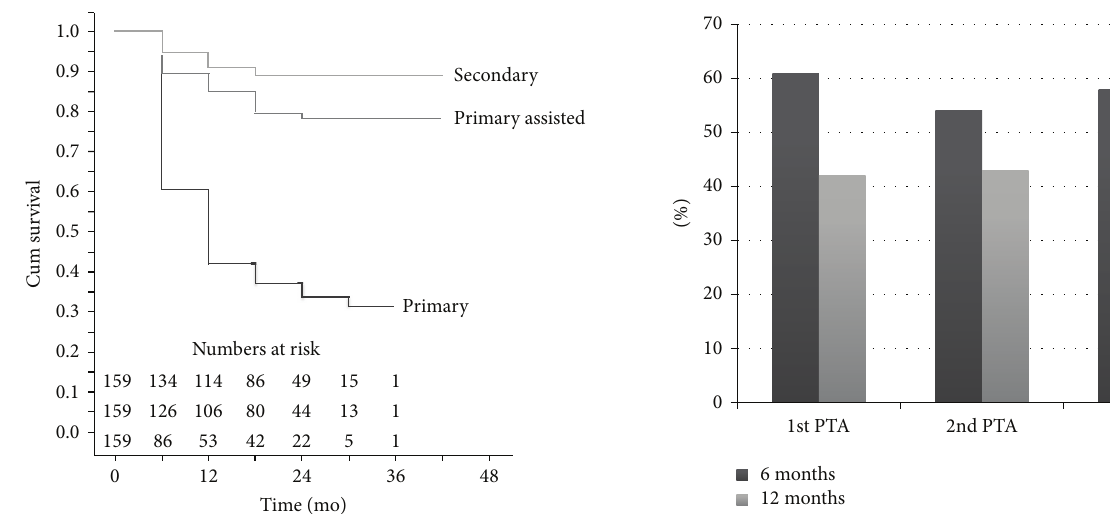
Figure 3: Kaplan Meier estimated patency.